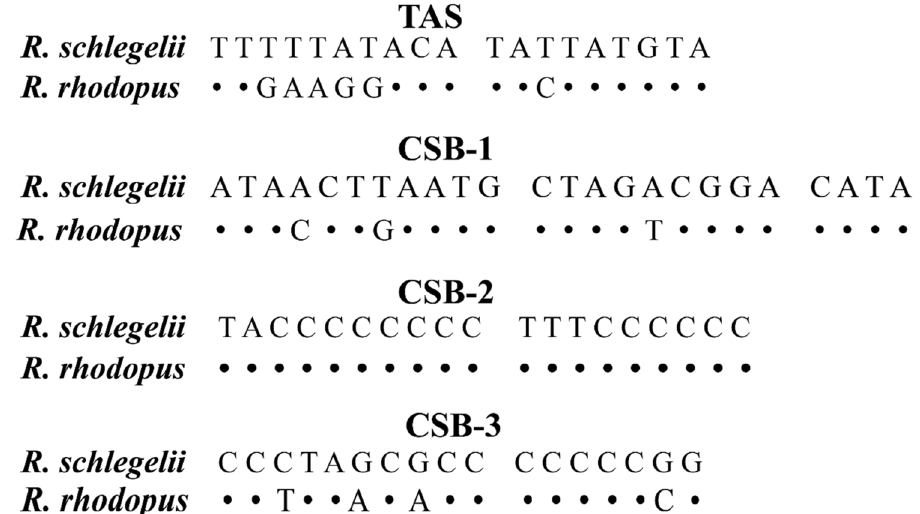
Figure 4. Structures and alignments of identified putative termination-associated sequences (TAS) and conserved sequence blocks (CSB1-3). Alignment gaps and nucleotides identical to the first line are indicated by a dot ( · ), respectively. Variable nucleotides are marked with corresponding